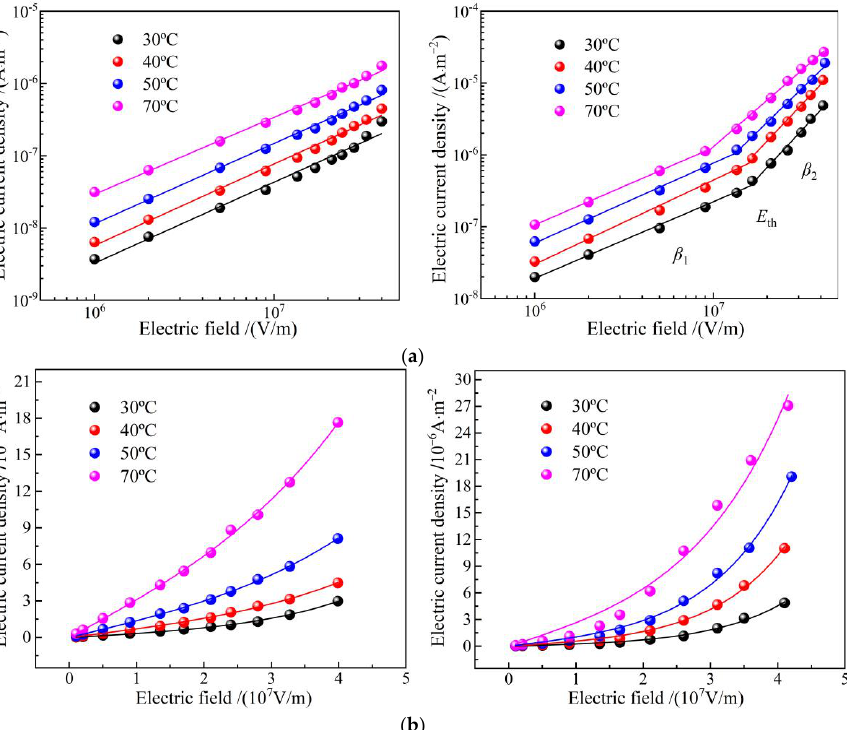
Figure 6. Electric conduction J-E characteristics of EPDM ( left panels ) and EPDM-g-GMO ( right panels ) at diverse temperatures from 30 to 70 °C in ( a ) double logarithm coordinates curves for stepwise linear fitting and ( b ) double linear coordinates for hopping conductance fitting. Table 4. Electric conduction characteristic parameters of EPDM-g-GMO at various temperatures.